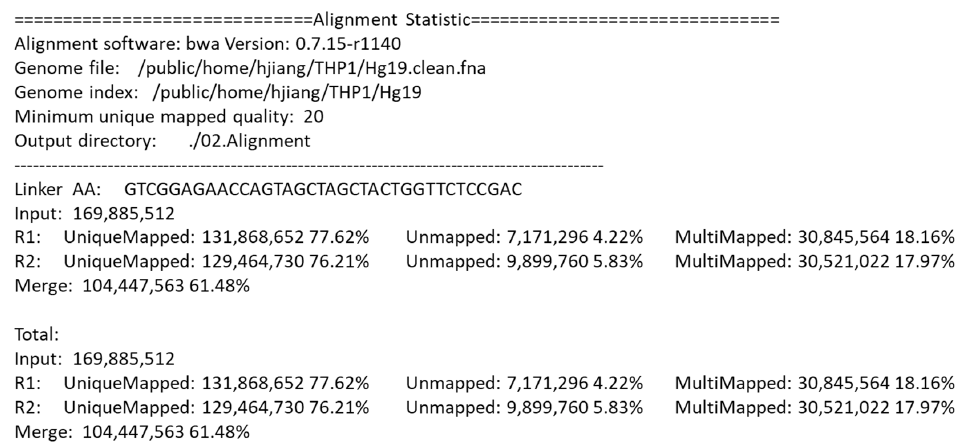
Figure 6. Statistics report of the alignment.